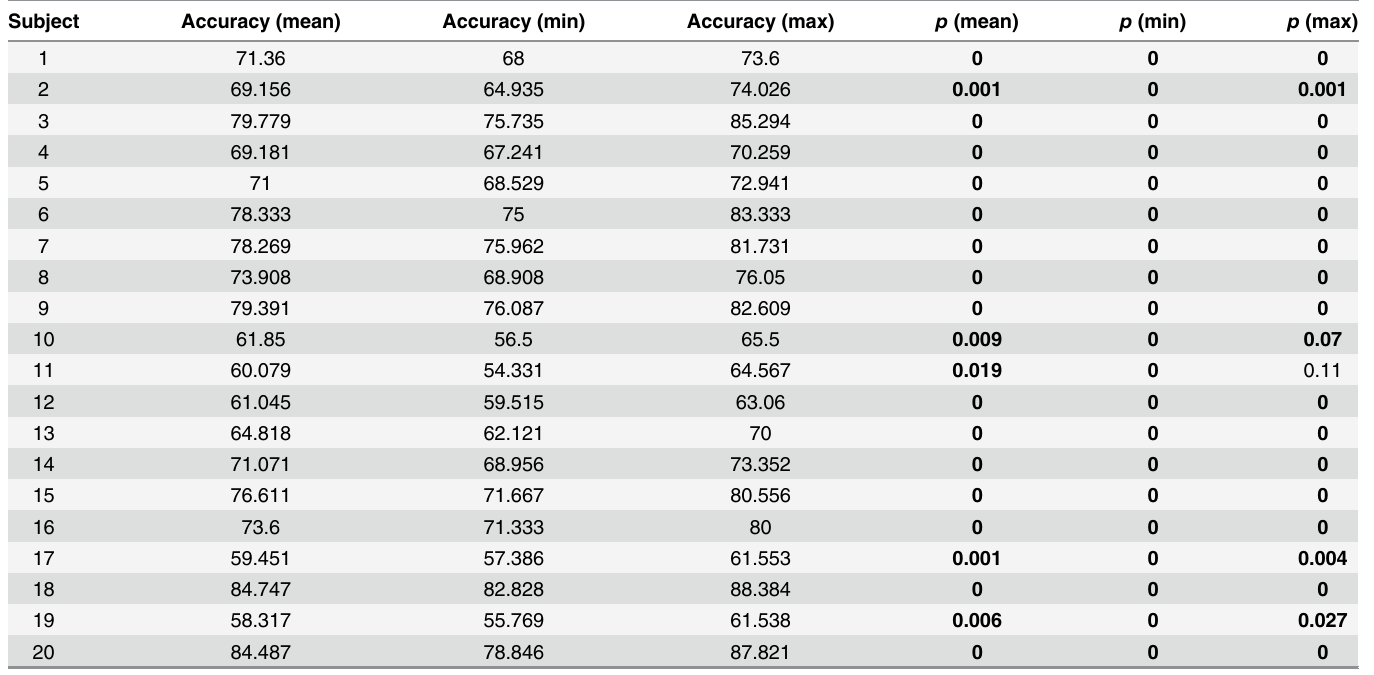
Table 6. Results Rotation Task Pe